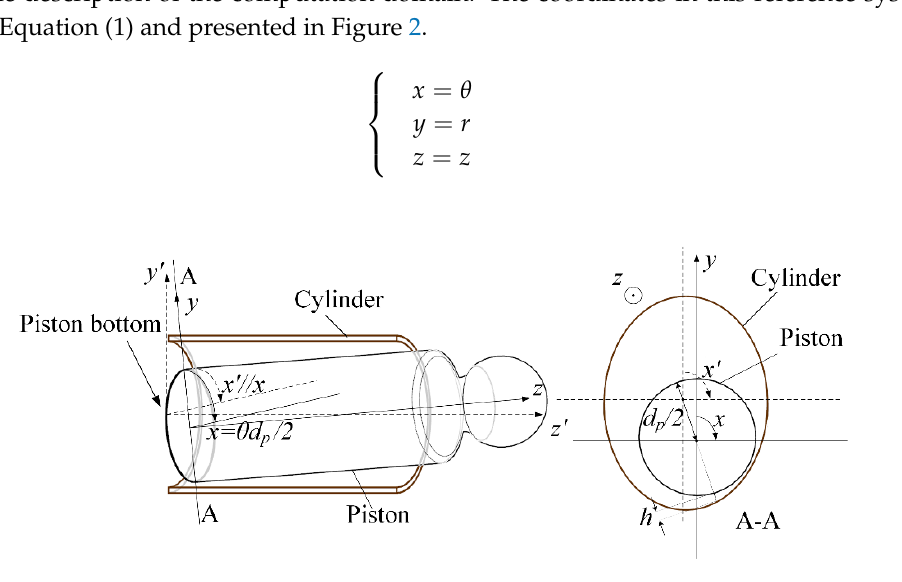
Figure 2. Definitions of coordinates and gap height.